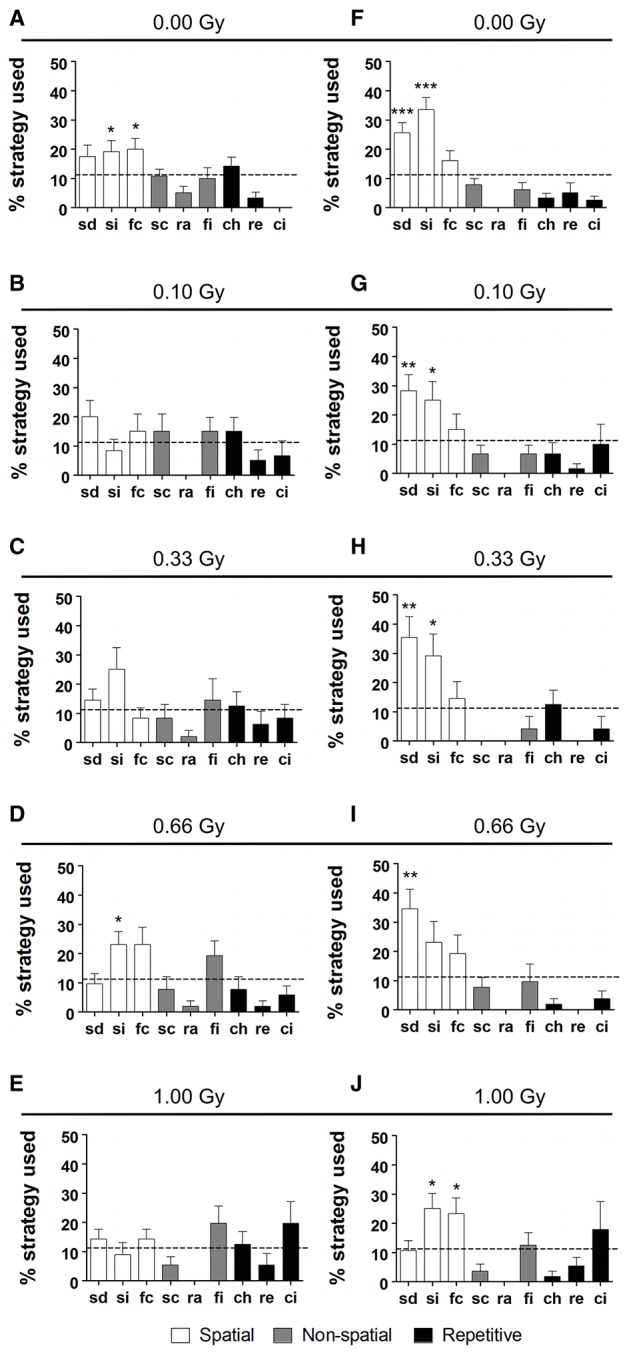
Irradiated mice have differential search strategy profiles halfway and at the end of MWM training. (A–J) Low-dose effects on spatial memory were confirmed when detailed strategy profiles were examined at day 5 (A–E) and 10 (F–J) of the MWM acquisition training. Whereas controls had a significant preference for spatial strategies on training day 5, this was not observed for the other doses, except for the 0.66-Gy irradiated animals that preferentially used the “spatial indirect” strategy. At training day 10, the two highest dose groups (0.66 and 1.00 Gy) still showed alterations in their preference profiles as compared to the sham-exposed condition, with only a significant use of “spatial direct” for the 0.66-Gy group and a significant use of both the “spatial indirect” and “focal correct” strategies in the 1.00-Gy exposed mice. Data are presented as mean ± SEM. *P < 0.05, **P < 0.01, ***P < 0.001. ch, chaining; ci, circling; fc, focal correct; fi, focal incorrect; Gy, Gray; MWM, Morris water maze; pe, peripheral looping; ra, random; sc, scanning; sd, spatial direct; si, spatial indirect.